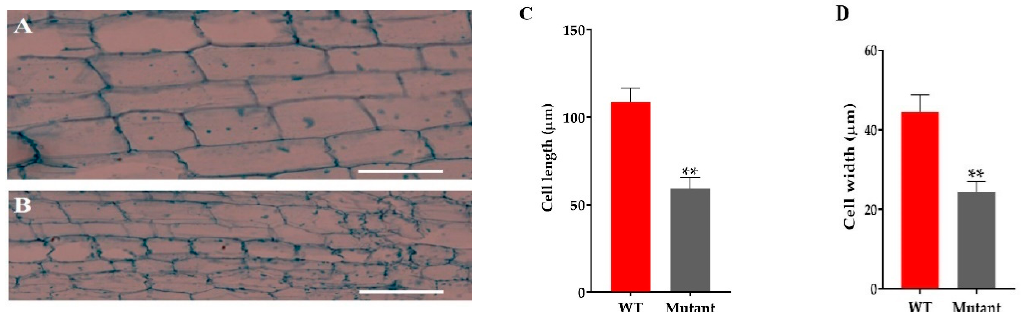
Figure 4. The microscopic analysis of culm cells of WT and mutant line GXU43_9. ( A ) WT second intermodal longitudinal length of the cell and ( B ) mutant plant GXU43_9, respectively. ( C , D ) Quantitative measurement of the length and width of the cells of mutant line (GXU43_9) and wild-type plants ( n = 15), Bars = 100 µ m. Data are the mean ± SD, “**” shows the significant difference at p ≤ 0.01 .